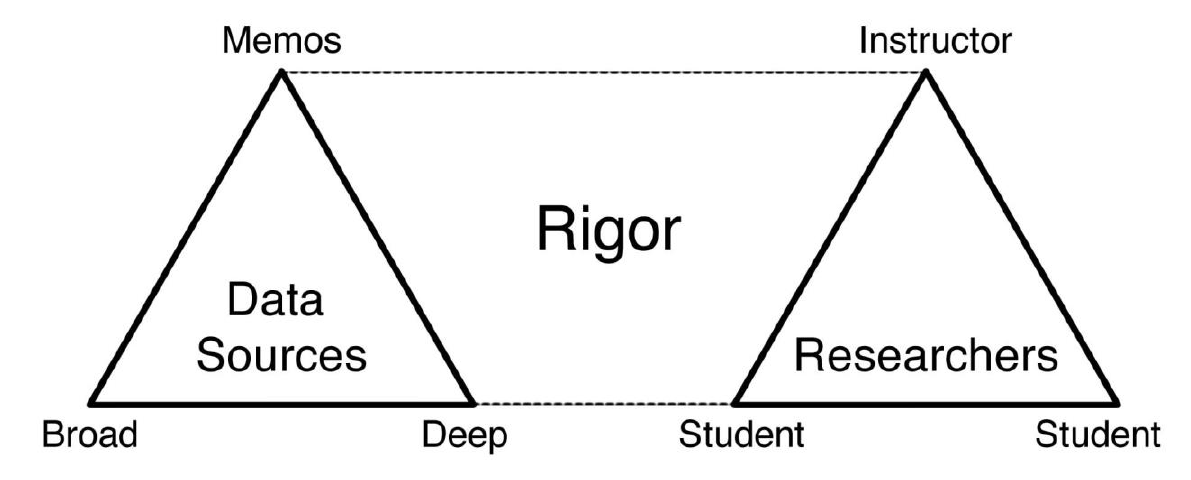
Figure 1. Parallel triangulation of data sources and researchers to support